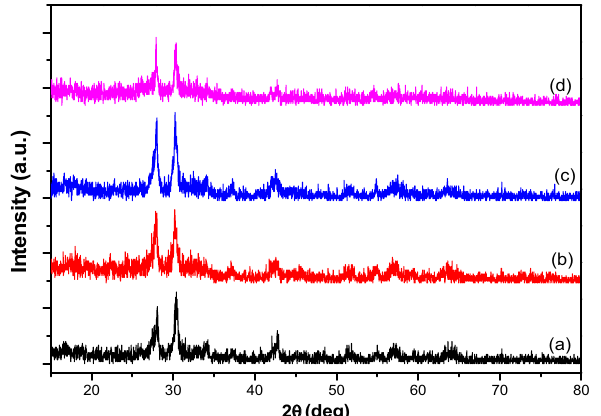
Figure 1. XRD patterns of ( a ) Fe 3 O 4 –FeVO 4 and ( b ) 5%, ( c ) 10%, ( d ) 15%RGO/Fe 3 O 4 –FeVO 4 nanocomposites.